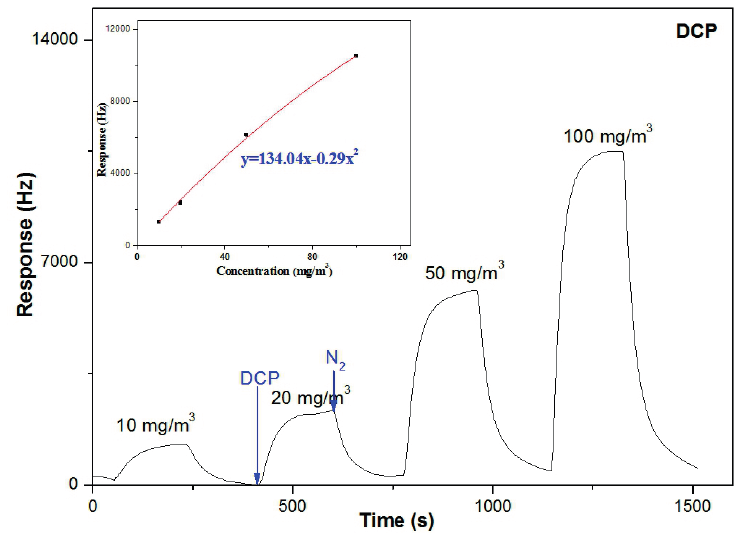
Figure 6. Real-time responses of the PLF sensor to DCP (3 min DCP and 3 min N 2 ).